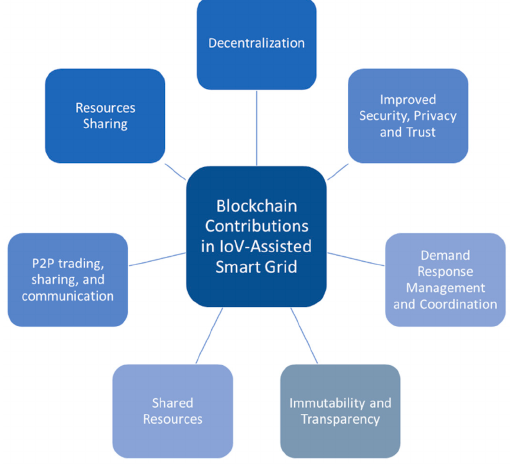
Figure 11. Blockchain contributions in IoV-assisted smart grids.